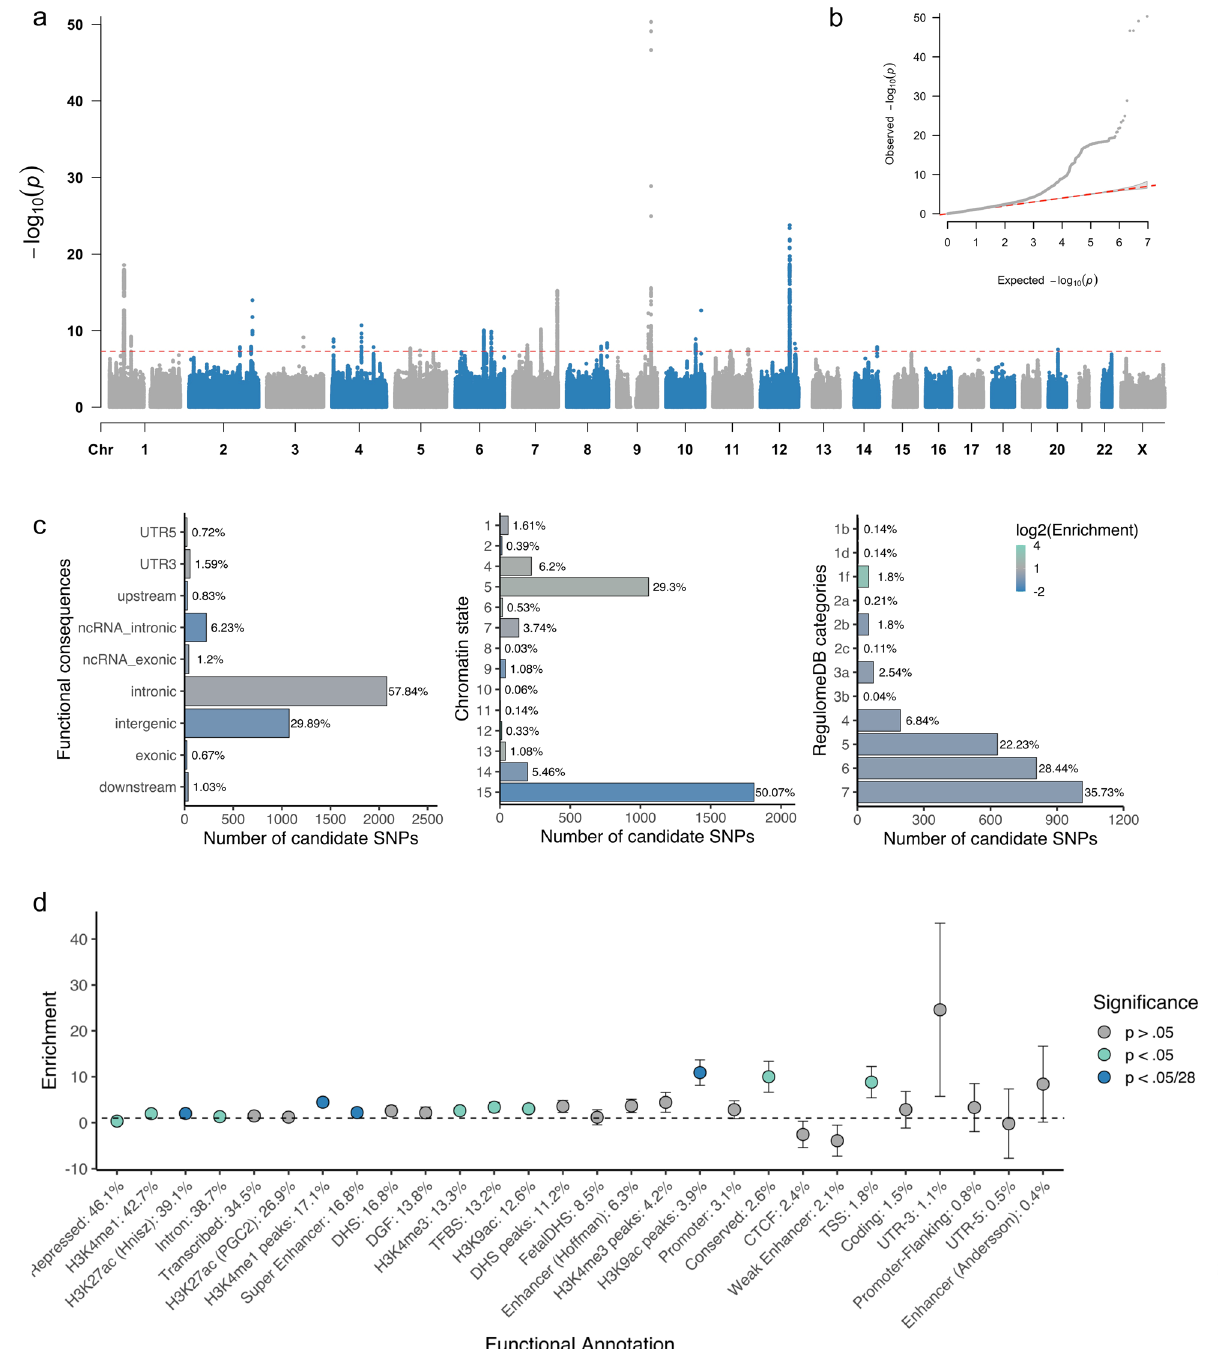
Fig. 1 SNP-based GWAS of cerebellar volume identi fi es 30 genome-wide signi fi cant loci. a Manhattan plot of − log10( P ) values from GWAS for cerebellar volume. b Quantile – quantile (QQ) plot of − log10( P ) values from GWAS of cerebellar volume; c Proportion of candidate SNPs with corresponding genomic location, RegulomeDB score and brain-speci fi c common chromatin state as assigned by FUMA. Log2(Enrichment) values are colour-coded (depletion coloured in blue), and corresponding P values are available in Supplementary Data 3. d Enrichment (and standard errors) of cerebellar volume heritability in functional genomic categories, also available in Supplementary Data